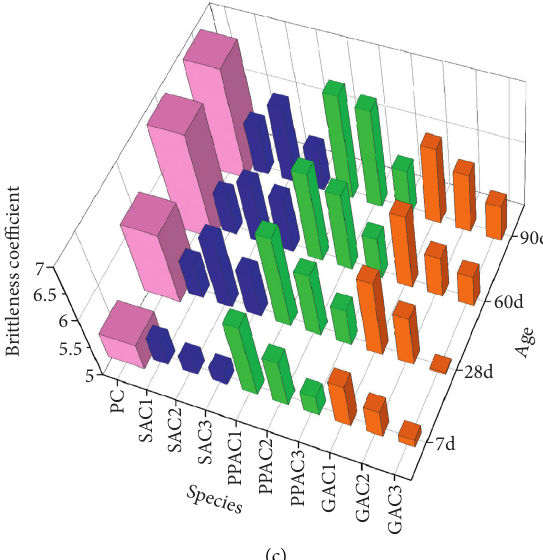
Figure 14: The characteristics of OSWA in place of cement. (a) Flexural strength; (b) compressive strength; (c) brittleness